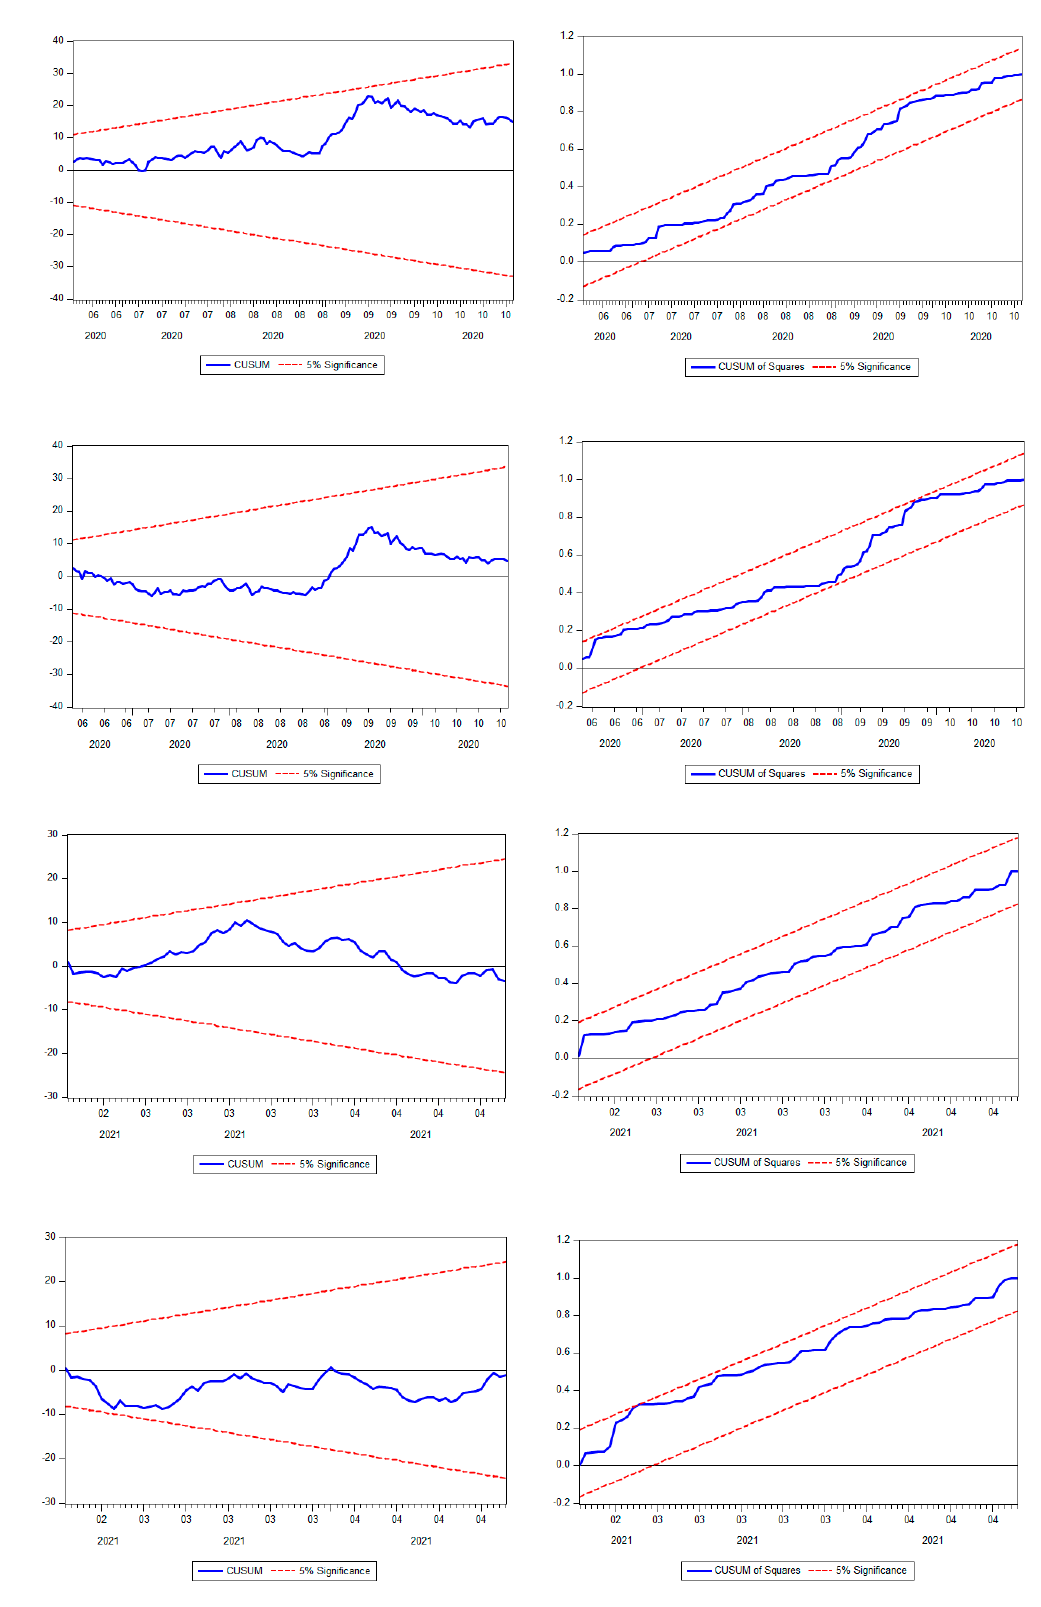
Figure 8. Plot of Cumulative Sum of recursive residuals (CUSUM) and Cumulative Sum of Square recursive residuals (CUSUM of Squares) tests for the parameter stability. Source: authors’ contribution using EViews 10 software.